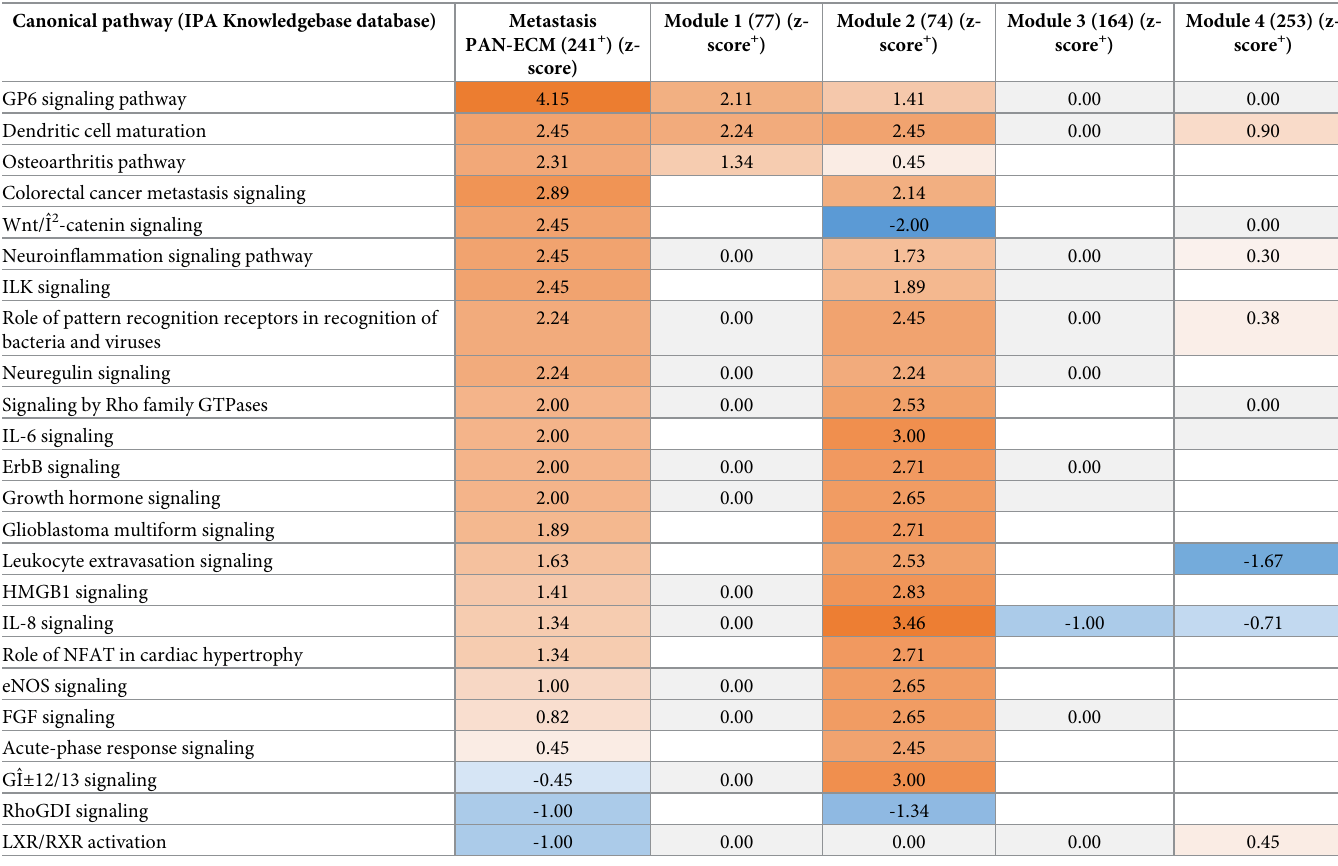
The canonical pathways involved in each modules was listed and sorted by z-score. + Number of